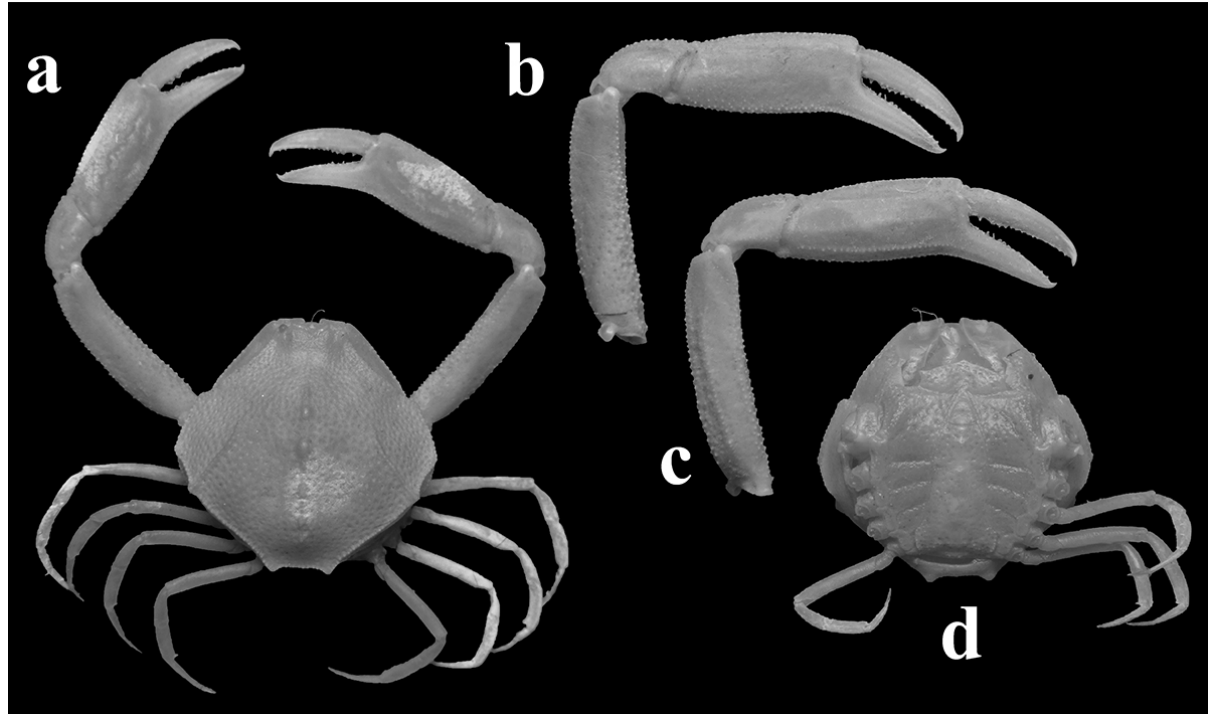
Figure 1. Bellayra sexangula gen. nov., comb. nov., lectotype, male (CL 7.24 mm, CB 7.85 mm) (ZSI-893/10). a , Habitus, dorsal view; b , right cheliped, outer view; c , right cheliped, inner view; d , carapace, ventral view.